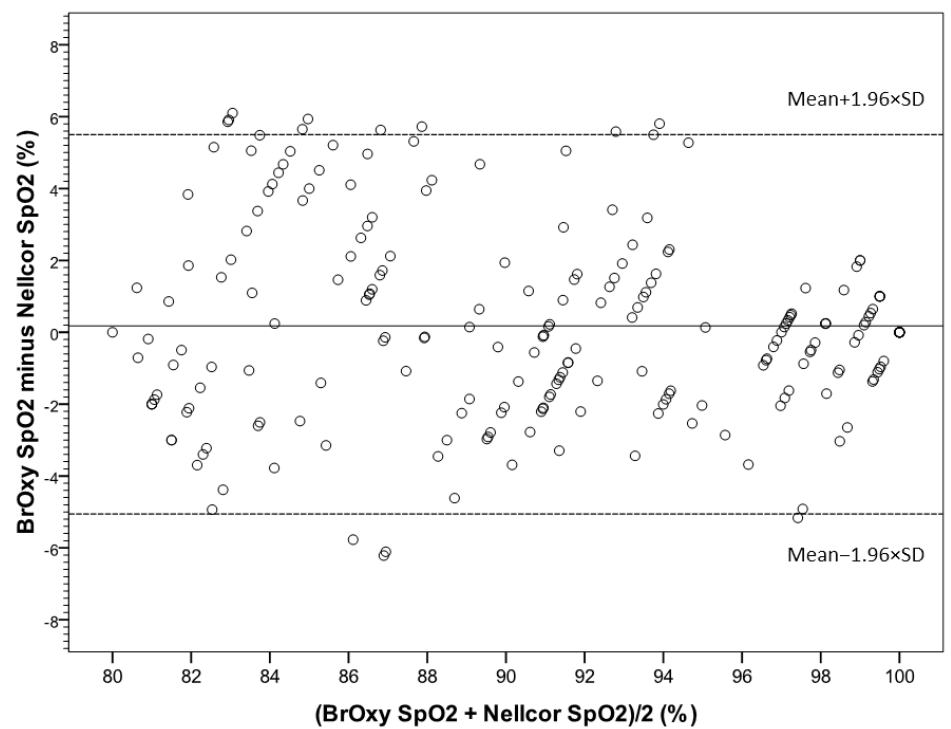
Figure 5. Bland-Altman plot, showing the average values of simultaneous SpO 2 as measured with BrOxy M and Nellcor TM in X -axis versus their differences in Y -axis. The mean difference (solid reference line) represents the mean error (bias), and the dashed reference linesare the upper and the lower limits of agreement between BrOxy M and Nellcor TM ( − 5.1 to 5.5%).